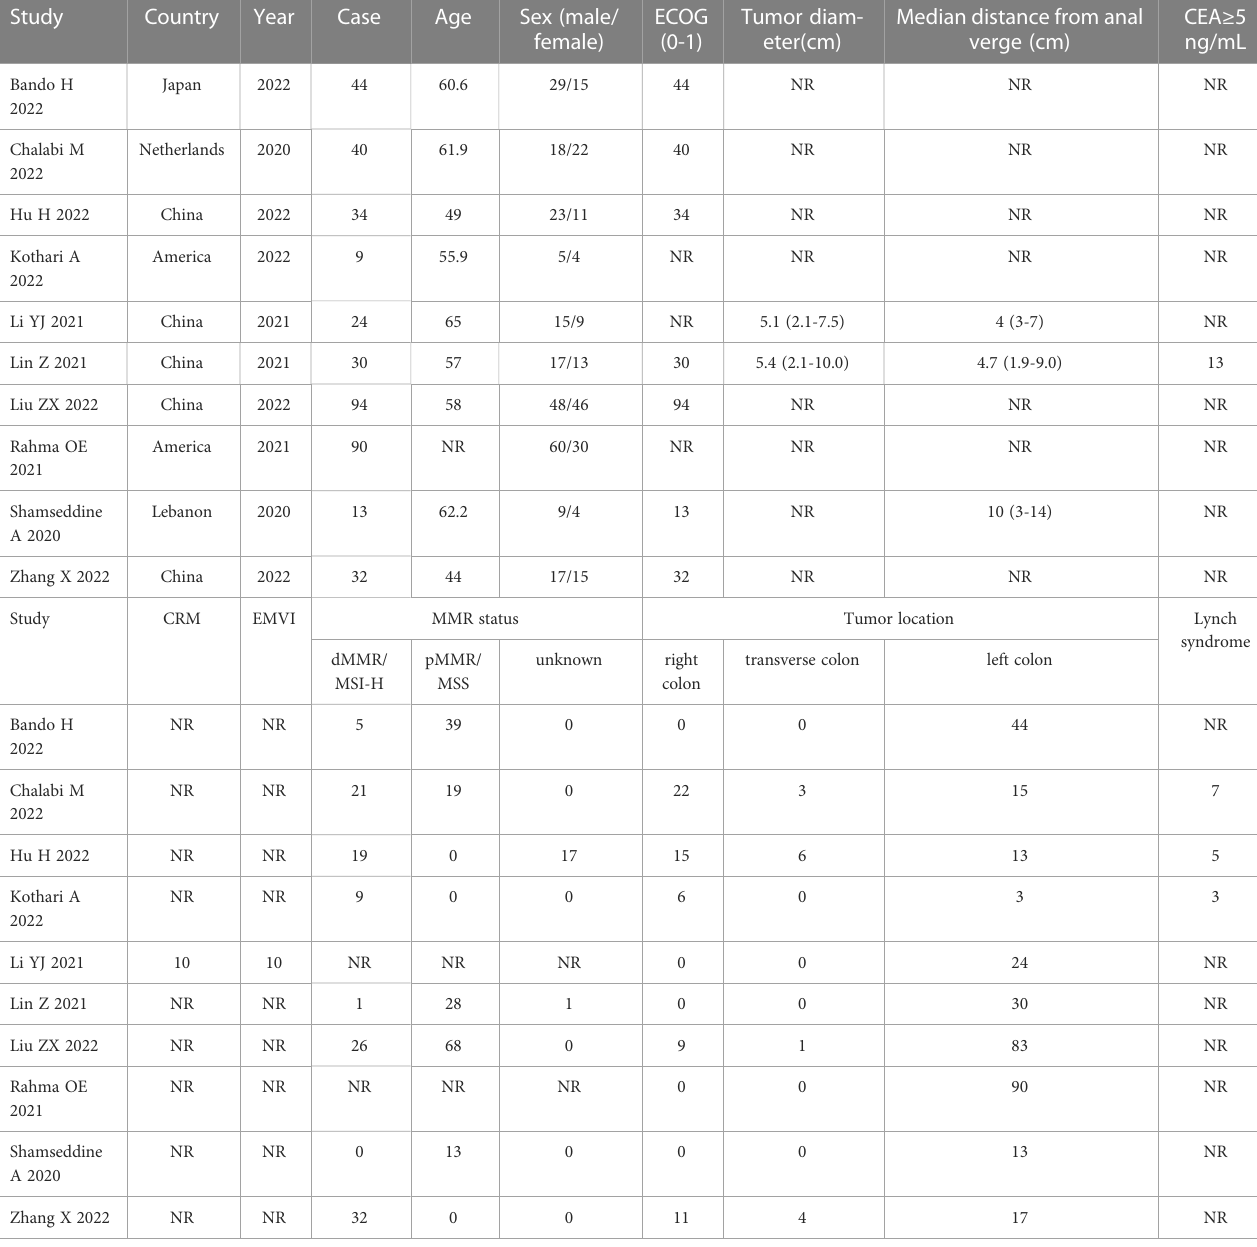
TABLE 1 Characteristics of the included